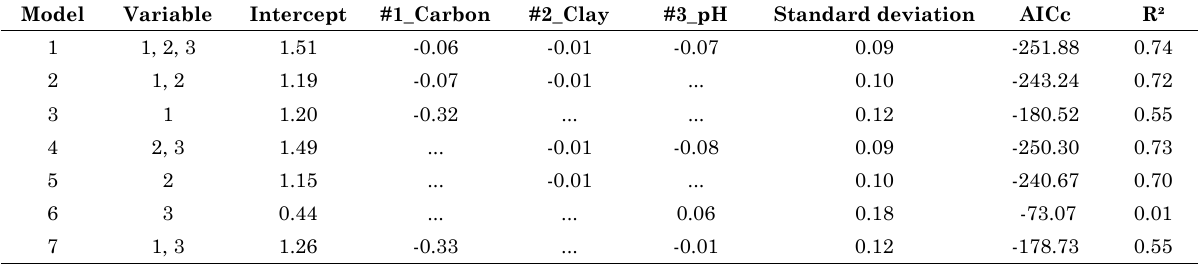
Table 2. Regression model selection results (ordinary least squares [OLS]) model